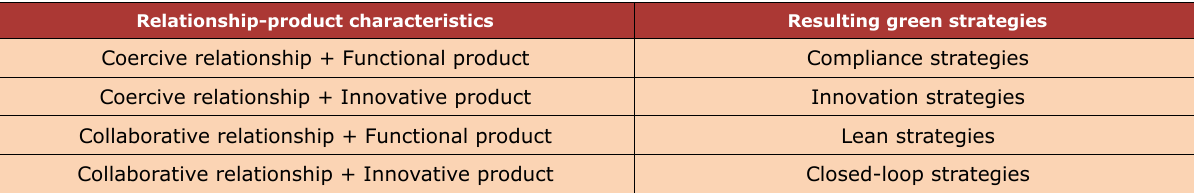
Table 4. Relationship-Product characteristics and resulting green